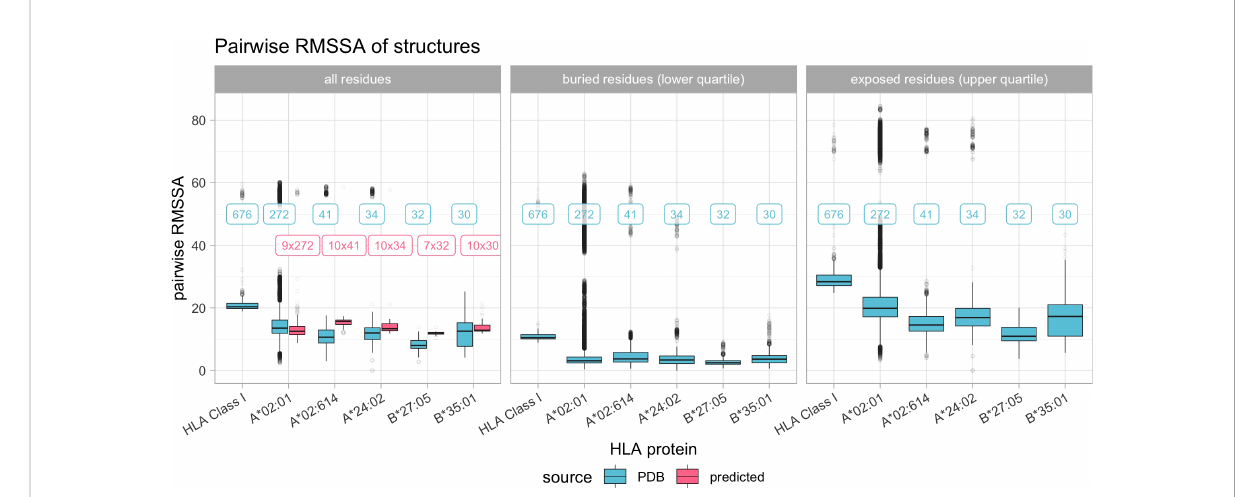
FIGURE 6 Boxplot indicating the pairwise root mean square surface area differences (RMSSA) across all experimental HLA Class I structures and pairwise across the most common HLA Class I structures. Color depicts the source of the structure data (blue indicates experimental structures from the PDB, pink indicates predicted structures as described in Materials and Methods). Horizontal panels consider separate distributions of all, only buried or only exposed residues. Boxplots depict the median (horizontal line), fi rst to third quartile (box); the highest and lowest values within 1.5× IQR (whiskers) and outliers (circles), respectively. Labels refer to the number of structures being compared, with blue labels referring to experimental structures and pink labels referring to predicted structures being compared with experimental structures.